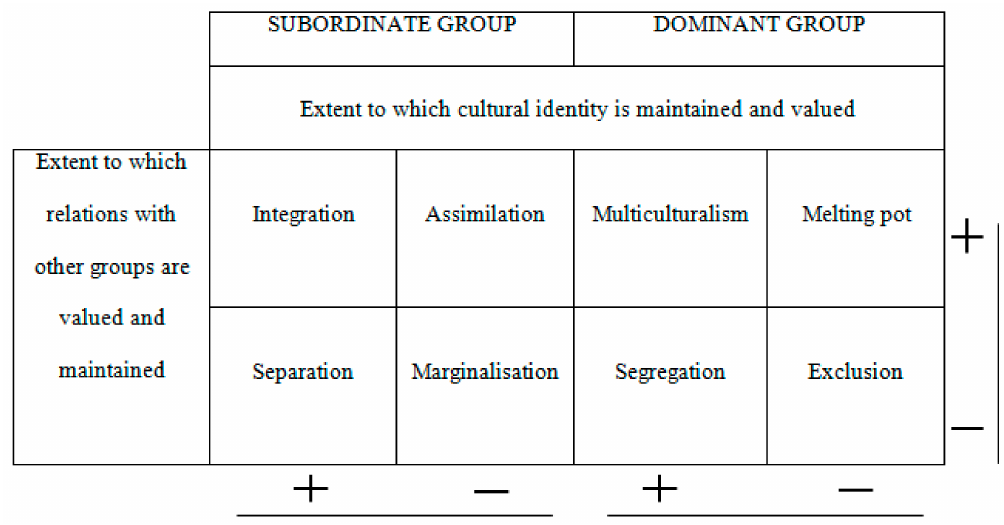
Figure 1. Berry’s acculturation model. Source: Berry (2001, p.